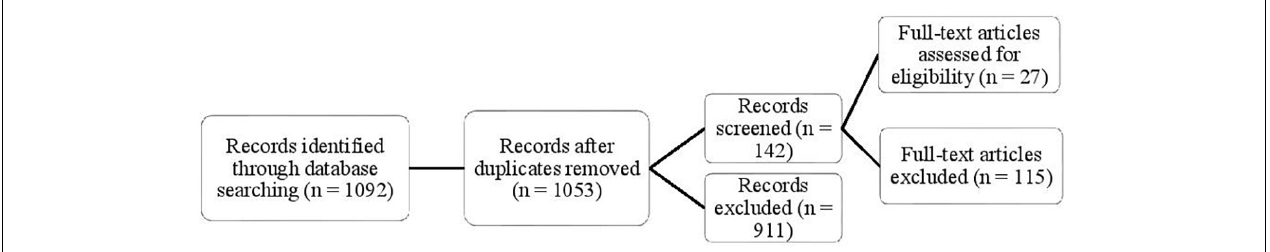
FIGURE 1 | Flowchart of Searching.